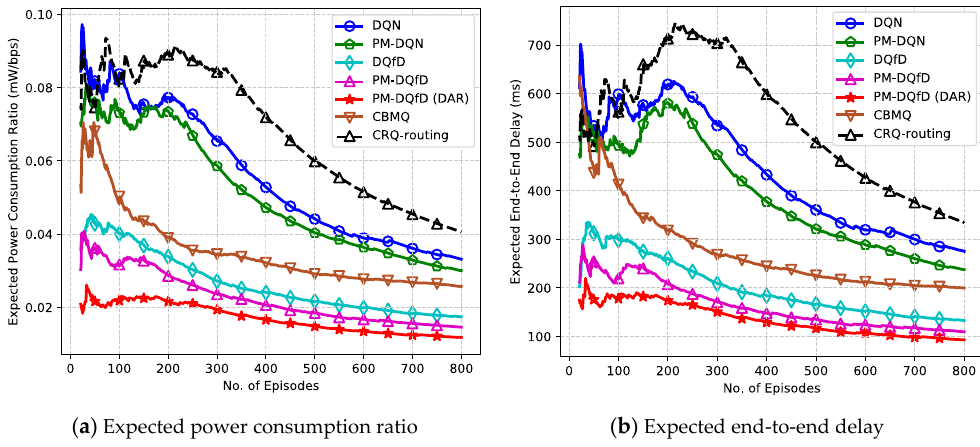
Figure 9 (a,b). Effectiveness properties versus number of episodes. Figure 9. ( a , b ) E ff ectiveness properties versus number of